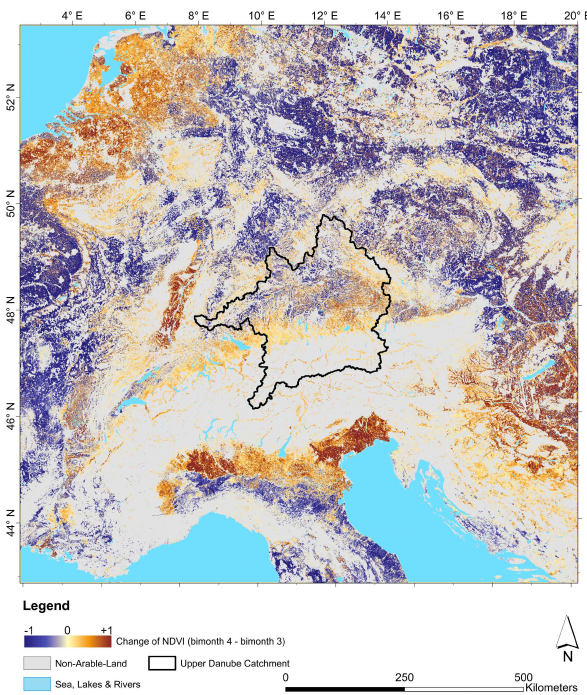
Fig. 4. Temporal change of MERIS NDVI, masked for arable land as a subtraction of Bimonth 4 with Bimonth 3.